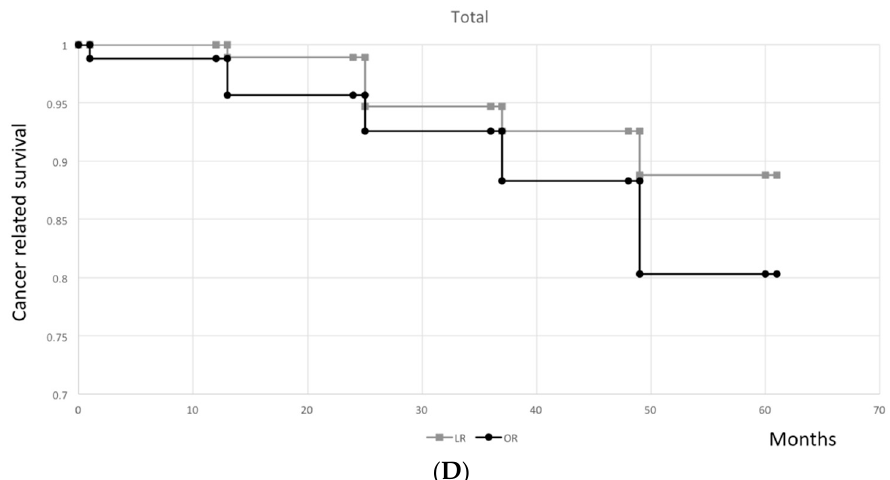
Figure 2. ( A ) Kaplan–Meier curve of cancer-free five-year survival in stage I patients ( p = 0.206); ( B ) Kaplan–Meier curve of cancer-free five-year survival in stage II patients ( p = 0.713); ( C ) Kaplan–Meier curve of cancer-free five-year survival in stage III patients ( p = 0.426); ( D ) Kaplan–Meier curve of cancer-free five-year survival in all stage patients ( p = 0.328).